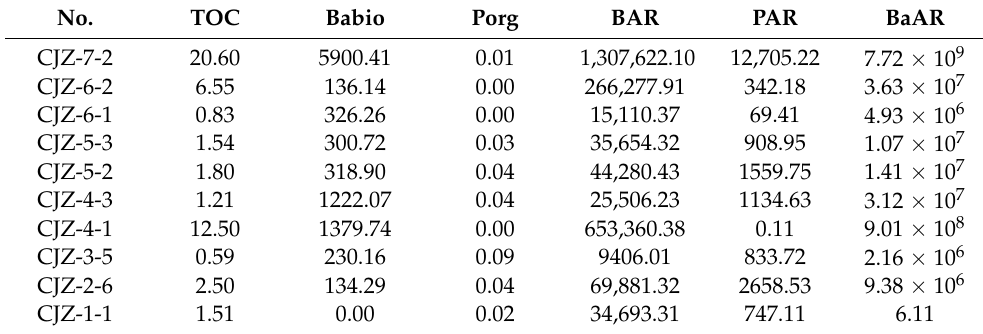
Table 5. The indexes of productivity of Benxi − Shanxi Formations in the Liulin section. No. TOC Babio Porg BAR PAR BaAR CJZ-7-2 20.60